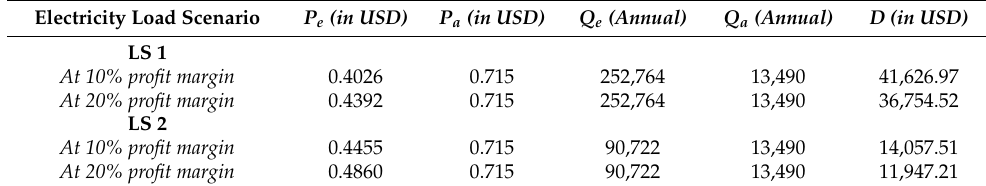
Table 5. Economic benefit to consumers